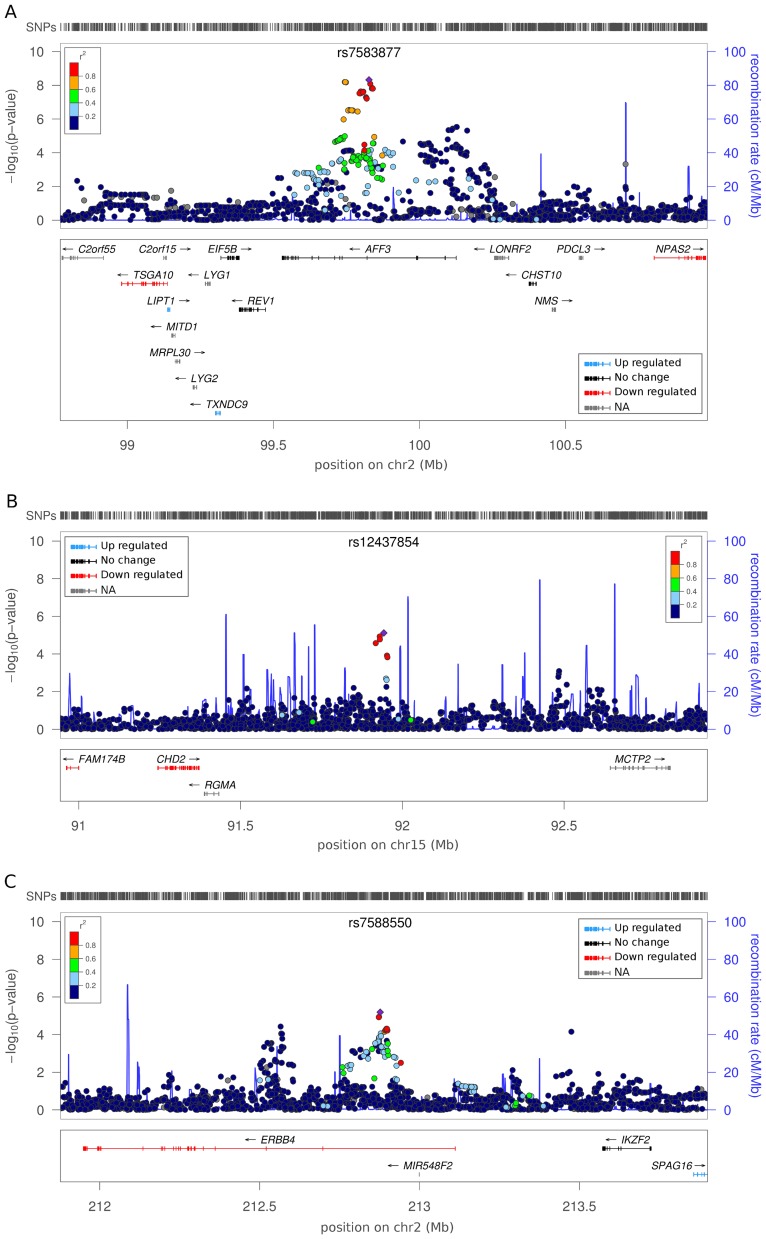
Regional association plots for top ranked SNPs with associated gene expression data.Panels represent independent signals for the primary DN and ESRD analysis. The color of the SNP symbol indicates the linkage disequilibrium (r2) with the index SNP which is colored purple. Blue and red gene colors in the lower part of each figure panel indicate up and down regulation in tubulointerstitial or glomerular DN kidney biopsies, respectively. Genes with no change in expression are indicated with black; no data on gene expression with gray color. (A) Association of rs7583877 with ESRD. (B) Association of rs12437854 with ESRD. (C) Association of rs7588550 with DN.